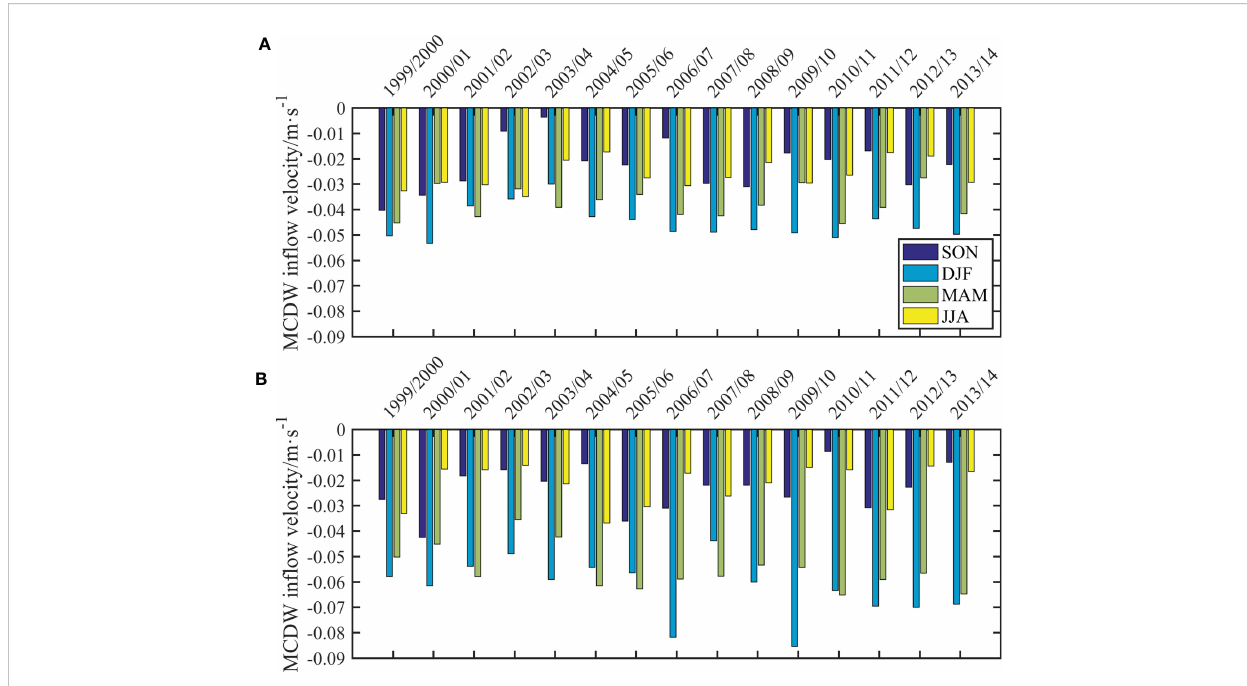
FIGURE 6 (A, B) The depth – transect averaged seasonal along-transect velocity component within the MCDW layer between 200 and 400 m along Transects 3 and 5, respectively. Negative values denote the on-shelf direction; the colors represent different seasons. MCDW, Modi fi ed Circumpolar Deep